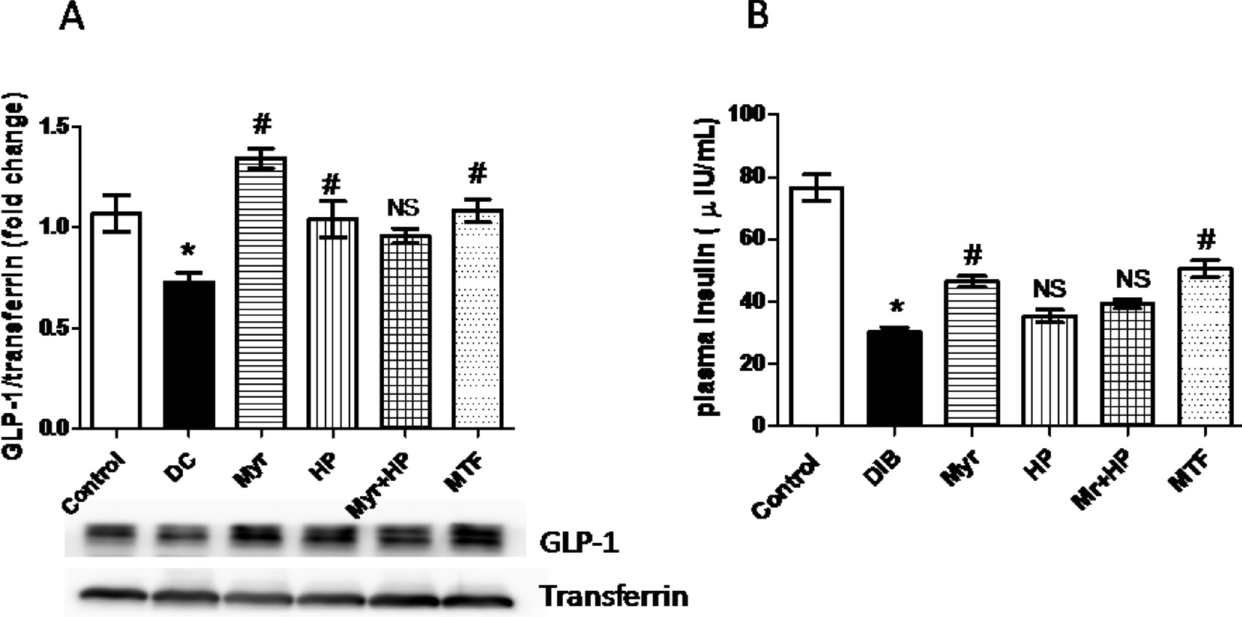
Fig 3. Estimation of circulating GLP-1 and plasma insulin levels. (A) Plasma GLP-1 levels estimated by immune-blot technique. DC rats showed reduced expression of GLP-1 protein compared to control. Myr, HP, and MTF were effective in elevating GLP-1 levels, while Myr+HP had no significant effect. (B) Plasma insulin levels. Compared to control, DC rats exhibited lower plasma insulin levels. Myr and MTF were efficient in recovering plasma insulin levels compared to DC. HP and Myr+HP had no significant effect on plasma insulin levels. Data are mean ± SD ( n = 6). � P < 0.05 when compared to control. # P < 0.05 when compared to DC and NS–not significant when compared to the DC